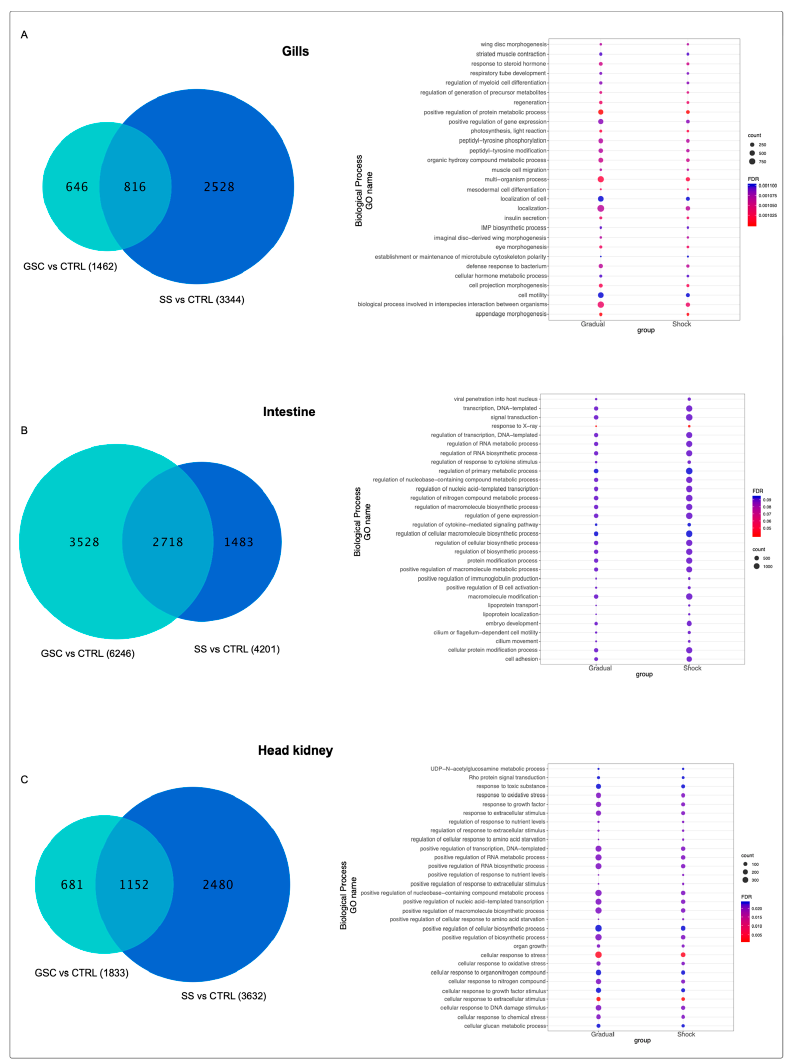
Figure 5. Differential expression analysis and GO enrichment of Atlantic salmon exposed to GSC and SS. ( A ) DEGs and GO enrichment of gills tissue. ( B ) DEGs and GO enrichment of intestine tissue. ( C ) DEGs and GO enrichment of head kidney tissue.